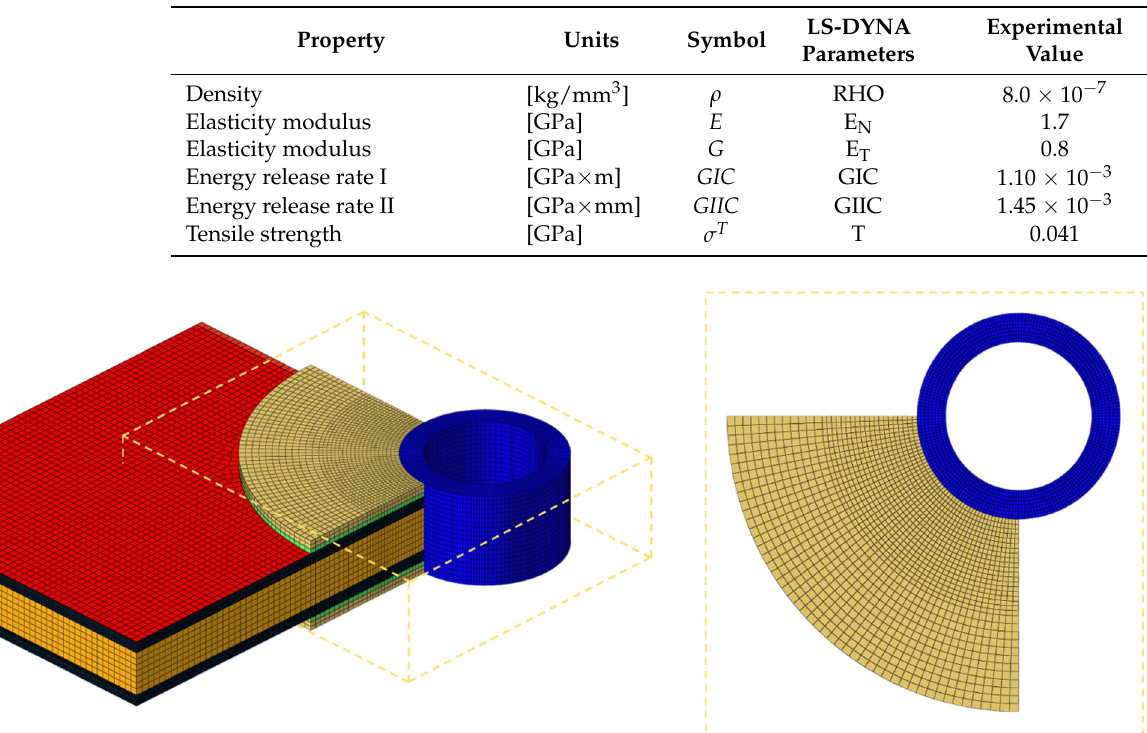
Table 3. Material properties of Araldite adhesive [16].